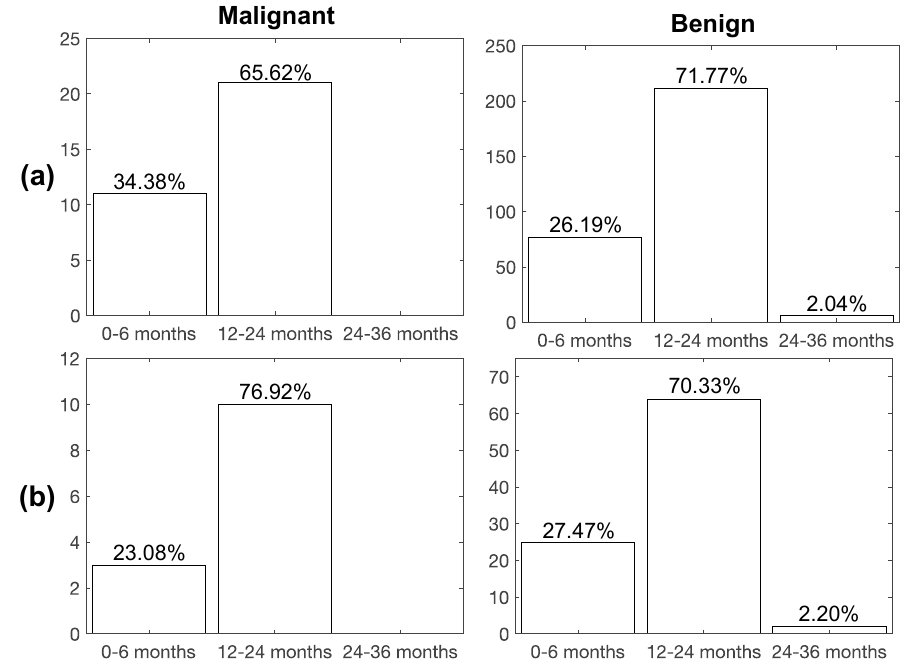
Figure 3. Percentage of LDCT second scan recalls for subjects with malignant and benign PN on the ( a ) discovery and ( b ) blinded test datasets, according to the reference standard (biopsy). Time interval for the second LDCT examination after LDCT baseline: (i) 0–6 months, (ii) 12–24 months, (iii) 24–36 months.